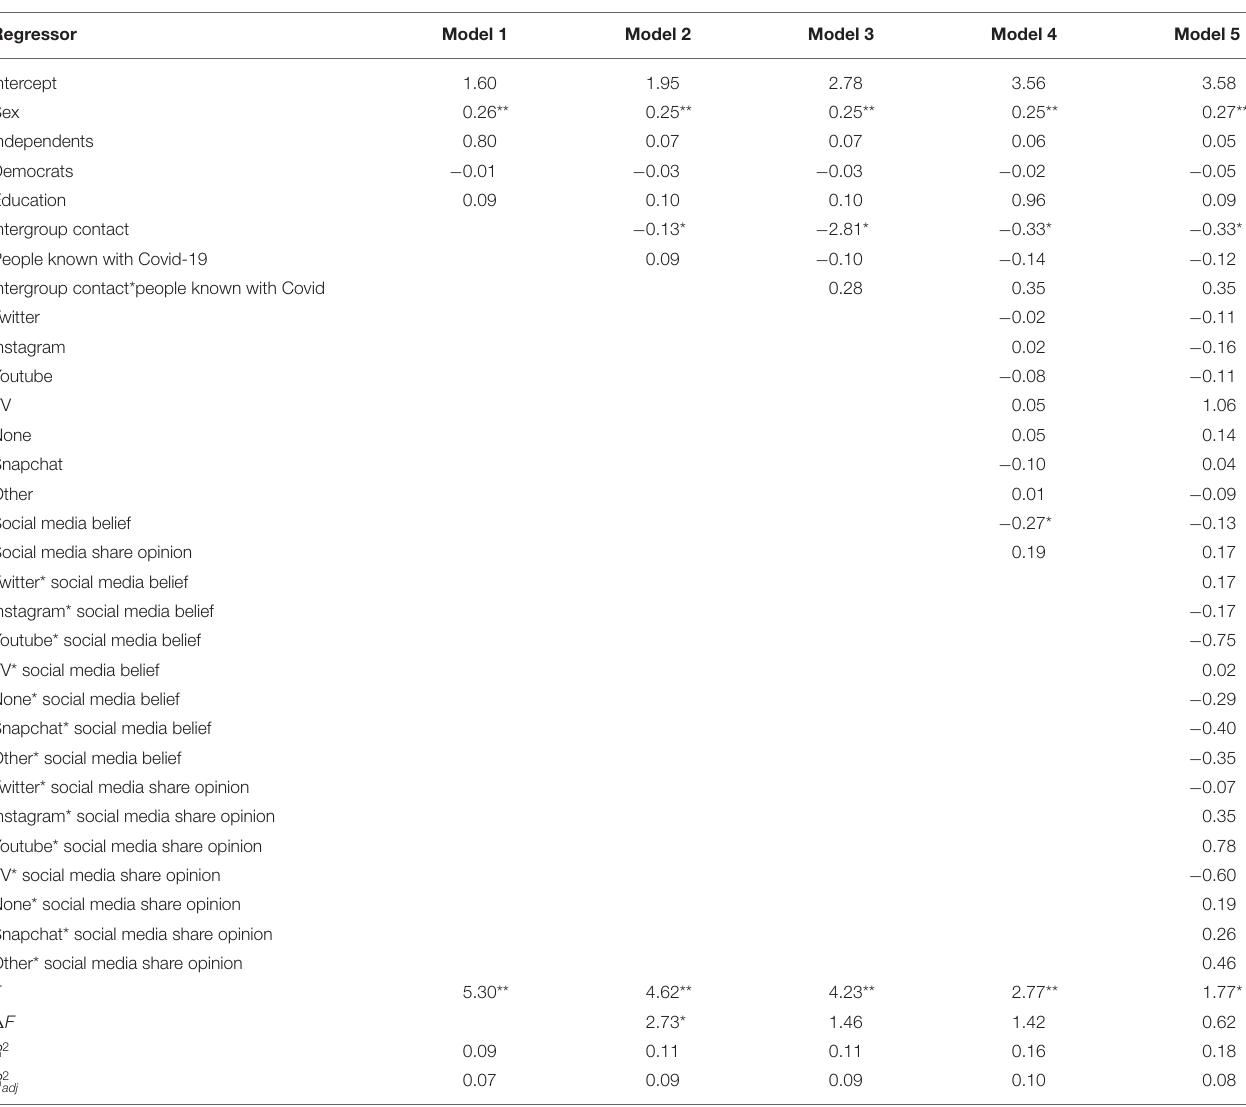
TABLE 5 | Regression model for intergroup